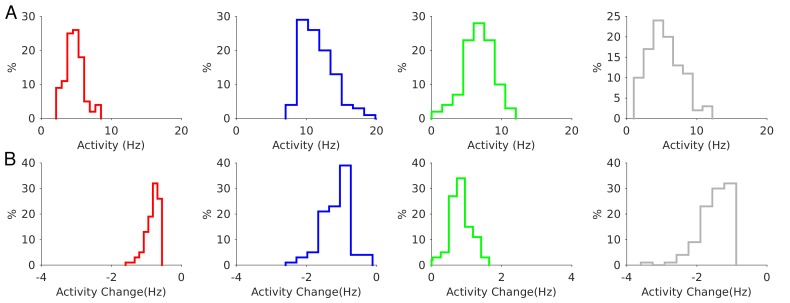
Model 1 with JEE>JEE*.Robustness to a change of ±10% in the interaction parameters. (A) Distribution of the population activities. (B) Distribution of the activity changes upon stimulation for Γopto=0.07mW.mm-2. Rates are averaged over 10s. Color code as in Figure 7. Parameters as in Figure 7.